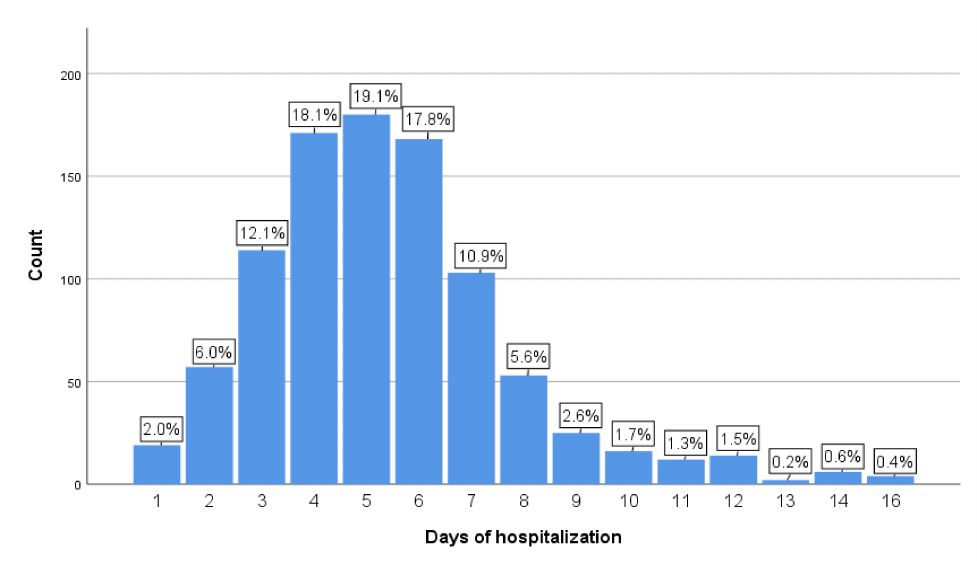
Figure 2. Frequency and percentage of the LoS in hospital in 944 children. LoS in days is shown as horizontal axis and frequency (%) as the vertical